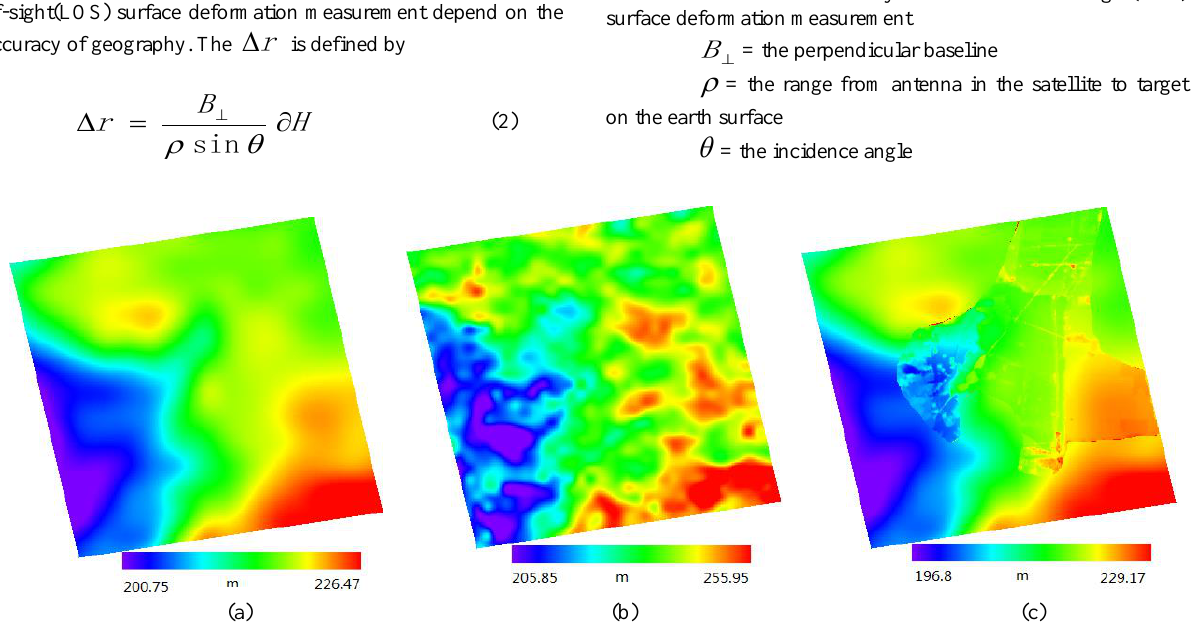
Figure 3. Different DEM figures with resolution of 3